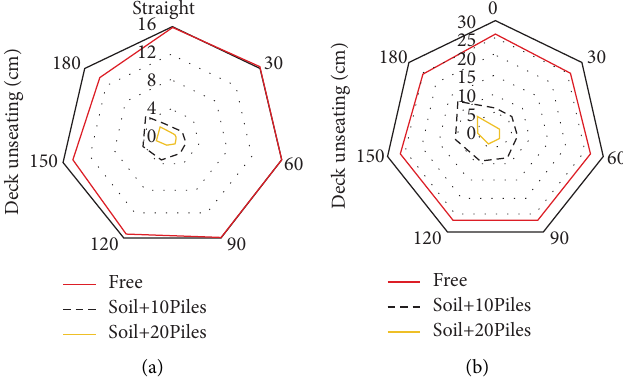
Figure 22: Abutment displacement in all bridge confgurations in the radial direction using GMs compatible to (a) DBE and (b) MCE response